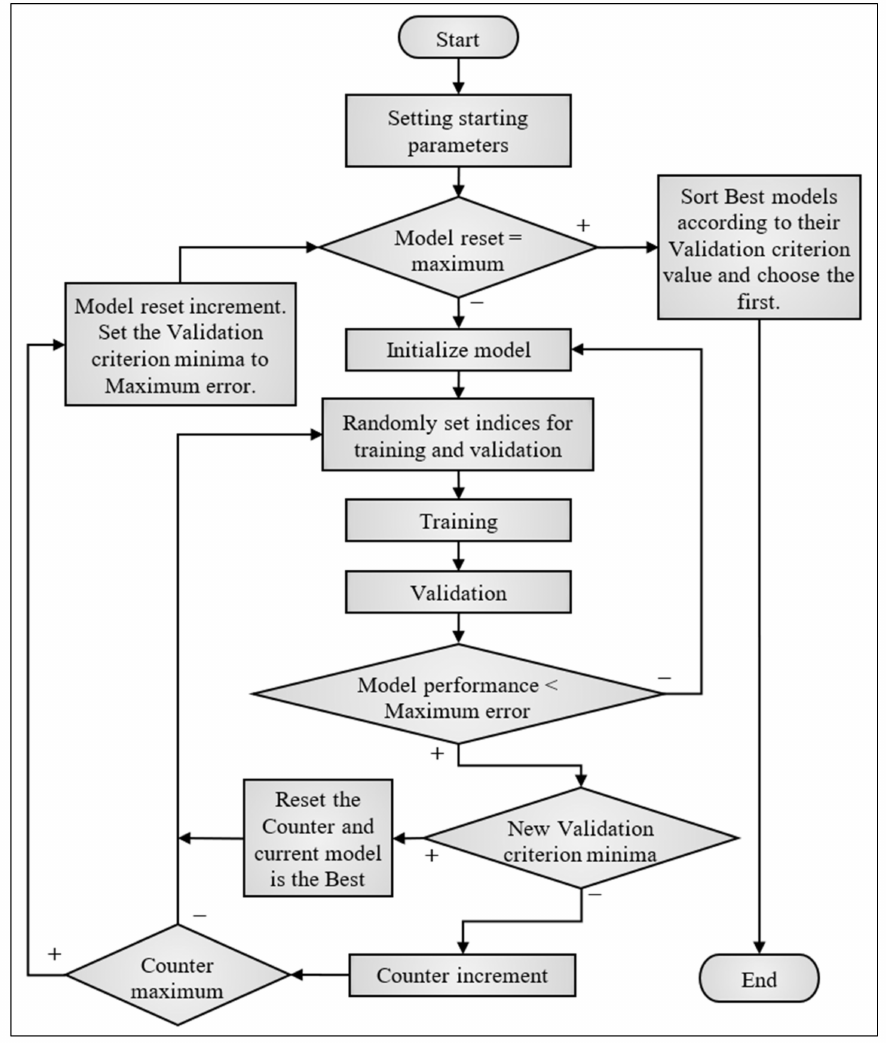
Figure 5. Validation